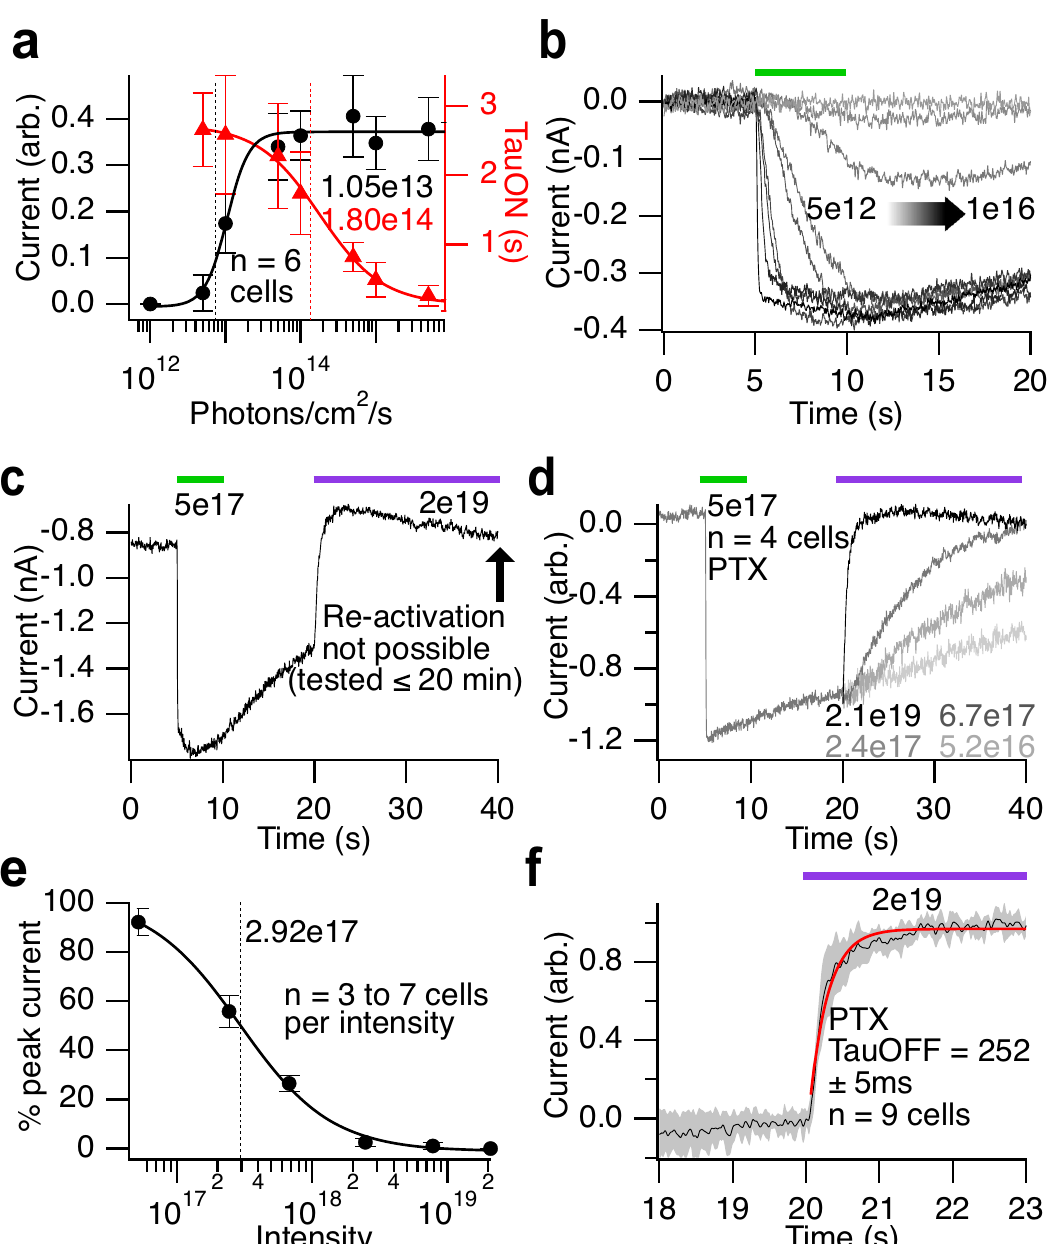
Fig. 3 | Light sensitivity of the JellyOp-triggered GIRK current. a The light intensity required for 50% maximum GIRK current activation by green light ( P 50 ) was 1×10 13 photons/cm 2 /s (black trace; 5s stimulation at 500nm; show is mean± SD). The speed of GIRK activation increased at higher intensities (red; TauON 50 =1.8×10 14 photons/cm 2 /s; show is mean±SD). b Example traces used to generate the light intensity curves in ( a ). c , d JellyOp-triggered GIRK currents are inactivated within milliseconds by high-intensity violet (405nm) light, shown without ( c ) and with PTX pre-treatment ( d ). e Light intensity response curve